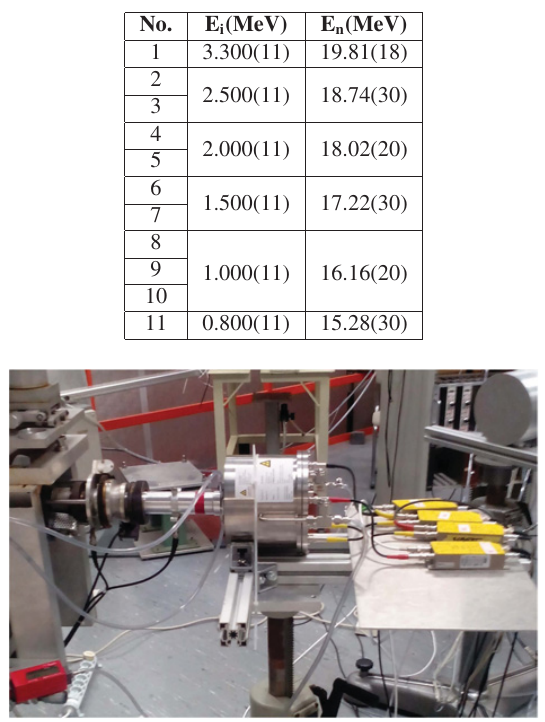
Table 1. Neutron irradiation data. E i : ion energy, E n : neutron energy.